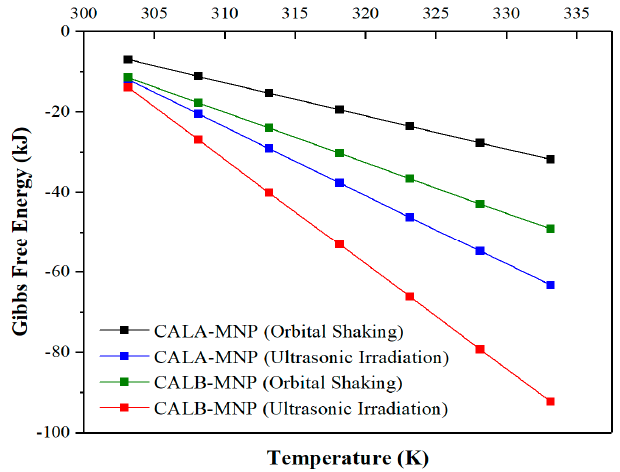
Figure 5. Gibbs free energy change for the enzymatic esterification as a function of temperature biocatalyzed by CALA-MNP or CALB-MNP under optimal conditions at orbital shaking (150 × rpm ) and ultrasonic irradiation (37 kHz, 300 W). Further details are given in Section 3.